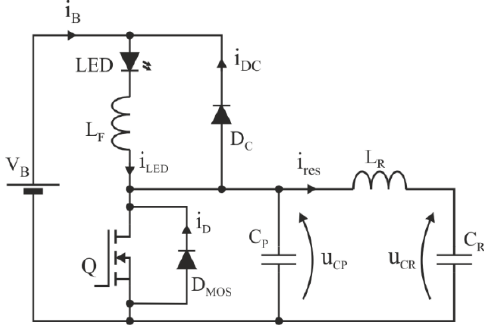
Figure 1. Schematic of the proposed circuit.